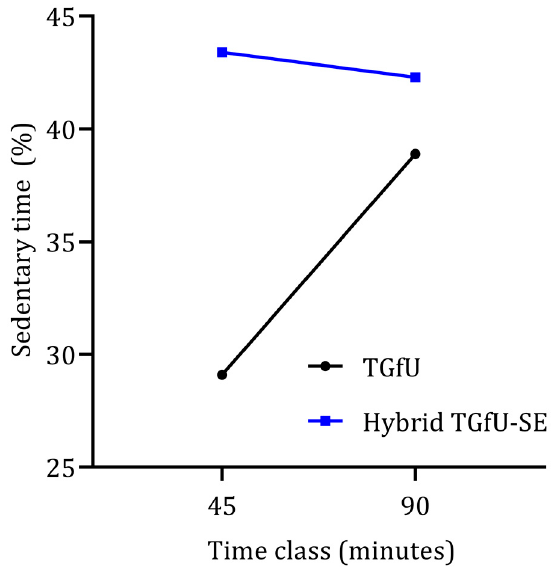
Figure 2. Sedentary time variation from 45 min to 90 min classes considering two different peda- gogical models (TGfU and hybrid TGfU-SE).